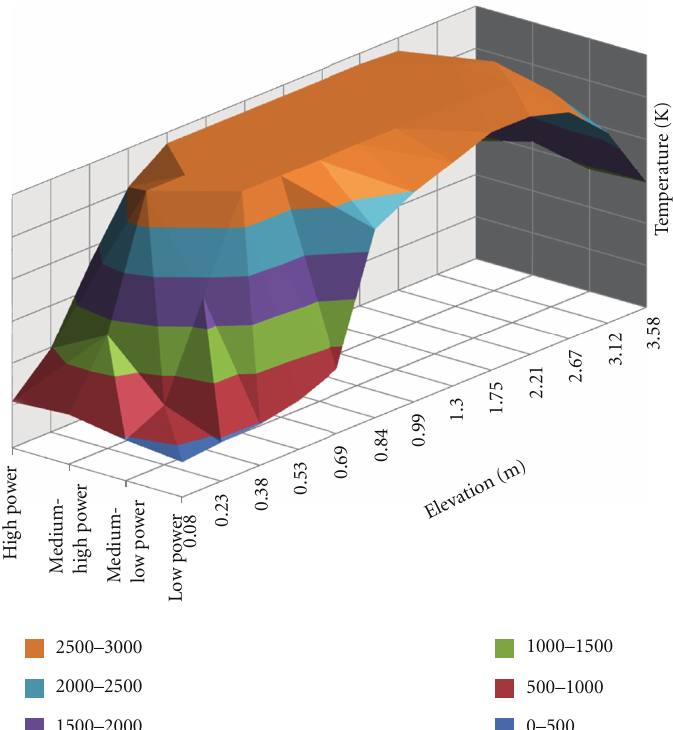
Figure 14: Core temperature distribution at 5.6 hours after reactor scram for a scenario with depressurization and termination of emergency water injection at 4.2 hours after reactor scram (CRD flows maintained).